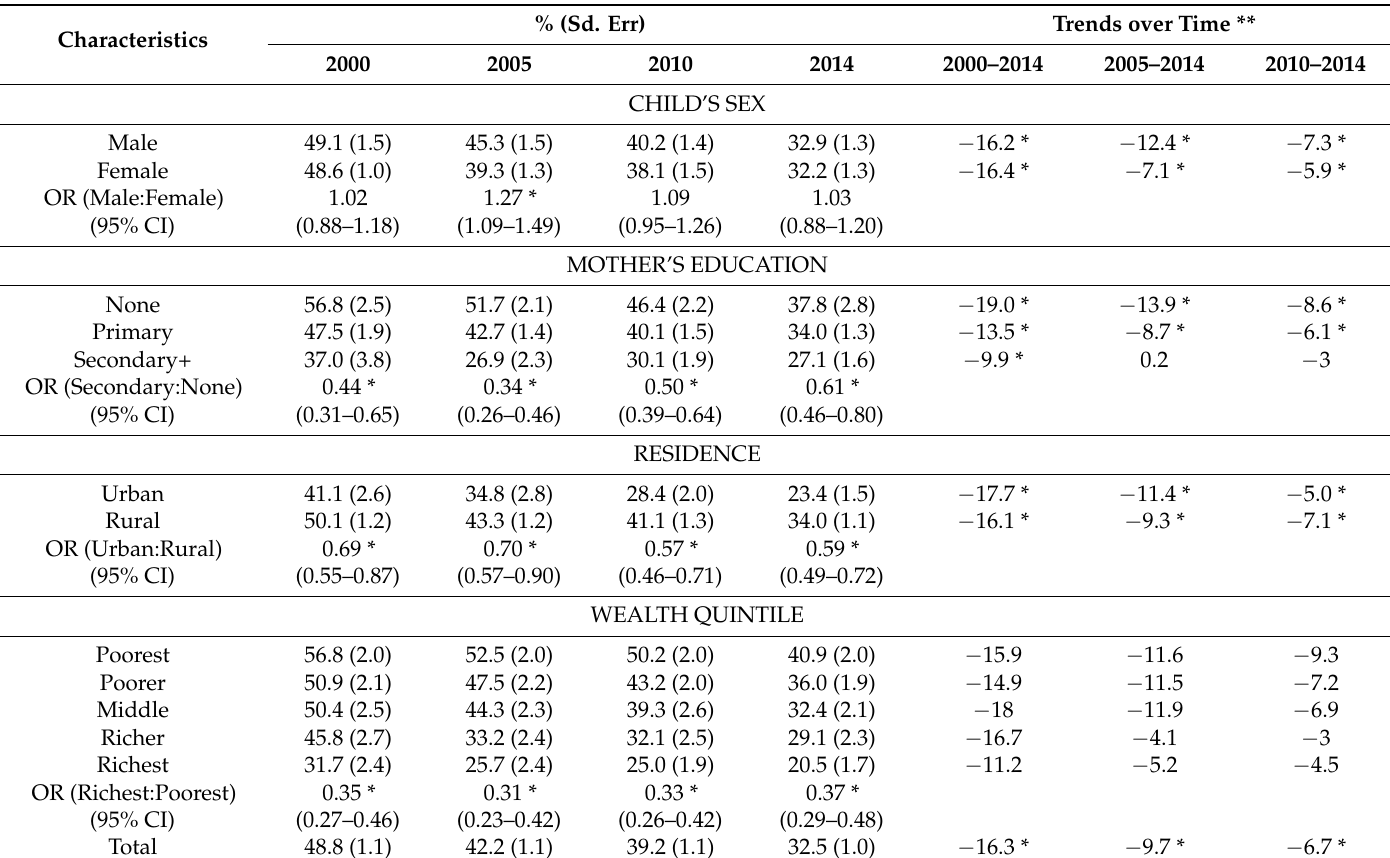
Table 2. Prevalence of stunting in children in the four surveys according to their social characteristics.